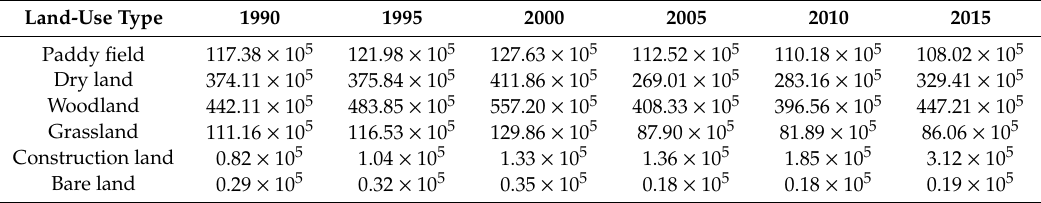
Table 7. Soil erosion amount of di ff erent land-use types from 1990 to 2015